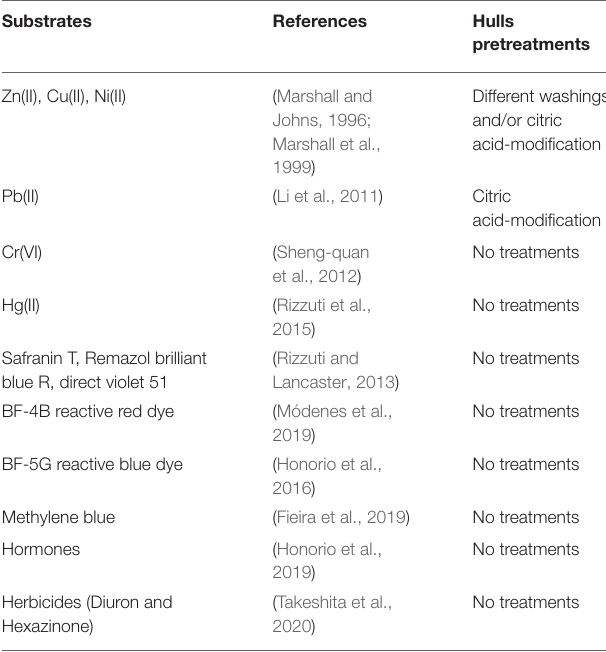
TABLE 1 | Inorganic ions and organic substances removed by adsorption with soybean hulls.